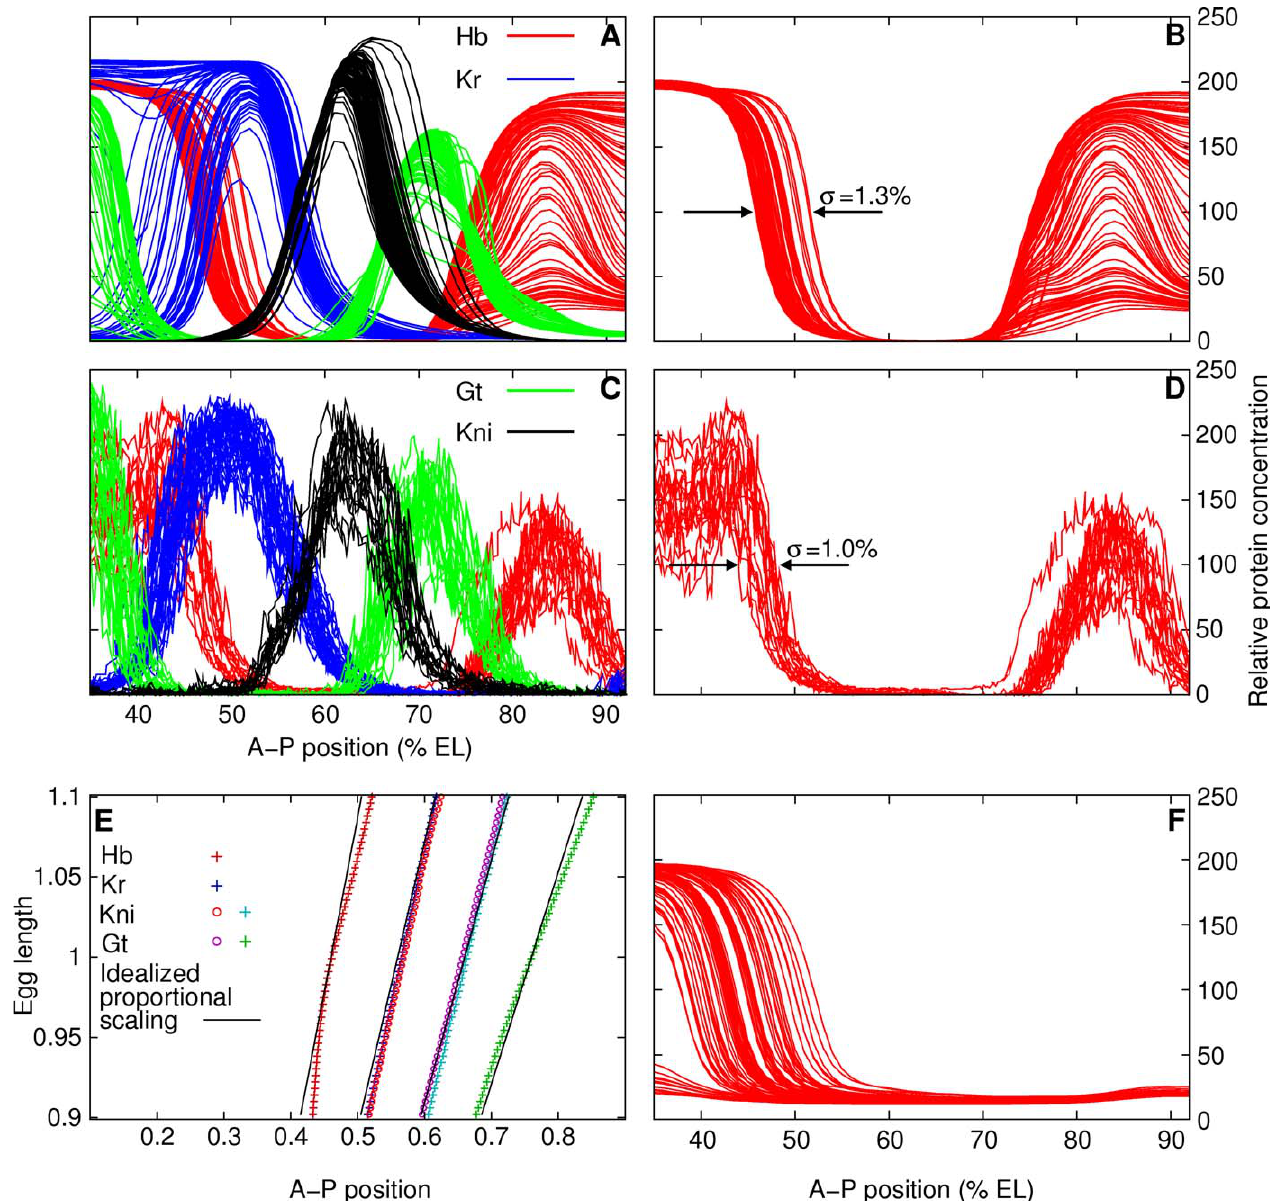
Figure 3. Gene Circuits Correctly Predict the Variation of Six Gap Gene Domain Borders (A) Modeled expression patterns of hb , Kr , gt , and kni in time class T8 (see Table 1) in simulations of the gene circuit using Bcd profiles from 88 individual embryos; compare with (C). (B) hb patterns produced by the model are shown separately. The position of the posterior border of the anterior hb domain has r Hb ¼ 1.3% EL and q Hb ¼ 5.6% EL. (C) Gap gene expression data from 83 time class T8 wild-type embryos. There are 15 expression profiles for hb , 30 for Kr , 18 for gt , and 15 for kni . (D) r Hb ¼ 1.0% EL and q Hb ¼ 3.6% EL in data. (E) Simulation of size variation. The egg length was varied from 0.9 to 1.1 to simulate a 20% range of egg lengths. The x -axis is the absolute position (relative position 3 length) of the gap gene borders. The border positions of the six gap gene domain borders that have low variance under Bcd variation (A) are plotted as points. The solid black lines show idealized proportional scaling of border positions with egg length. (F) In silico control experiment of simulating Bcd variation with gap gene cross regulation of hb turned off. The Bcd profiles used were the same as the ones used to produce (A) and (B). Fourteen borders are located anterior to 35% EL and are not visible in the region shown. r Hb ¼ 4.3% EL and q Hb ¼ 19.6% EL.